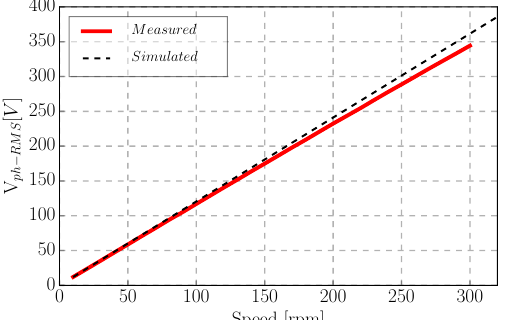
Figure 26. Measured and predicted no-load phase voltage versus rotor speed.